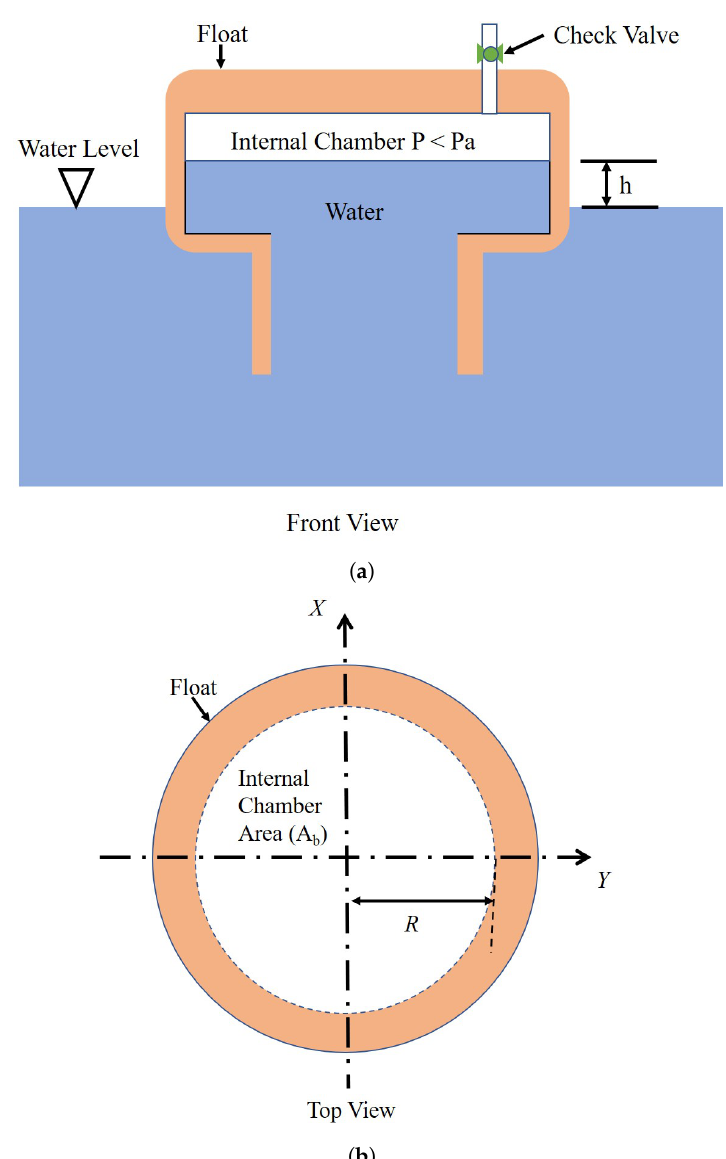
Figure 2. Suction Stabilized Floating (SSF) platform ( a ) Front View, ( b ) Top